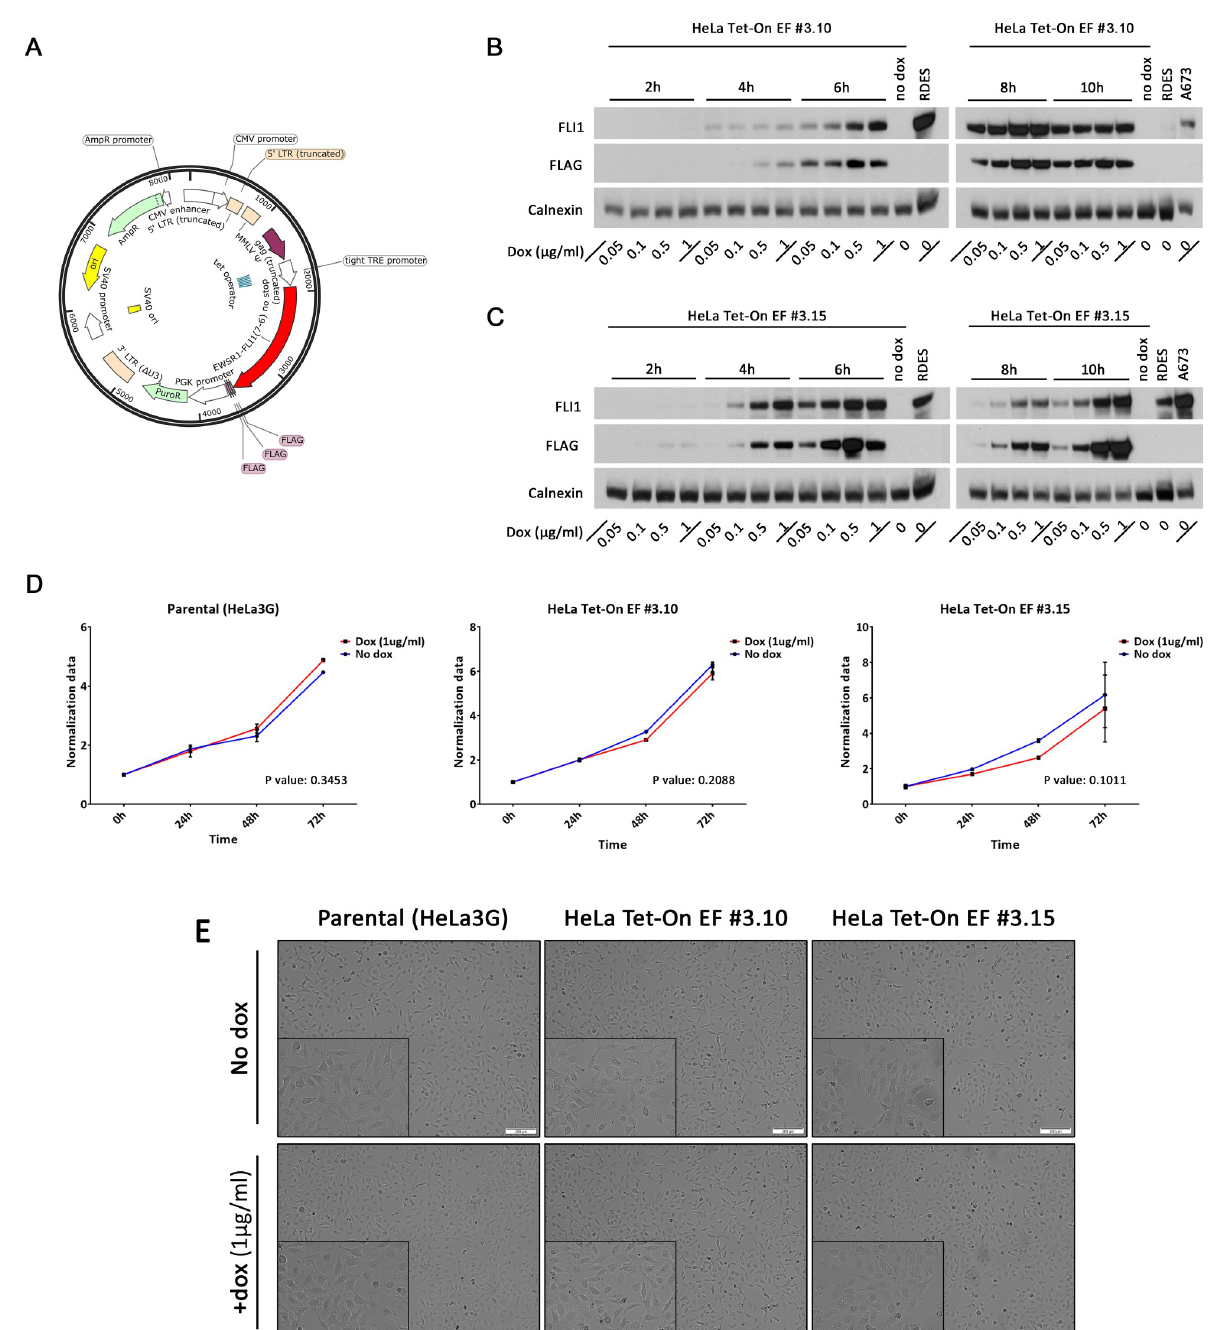
Fig 1. EWSR1-FLI1 expression in a HeLa Tet-On model. A. Schematic diagram of the retroviral vector used in the study. B, C. Western blot analysis showing the inducible expression of EWSR1-FLI1 in two HeLa Tet-On EF clones (#3.10 and #3.15) using the FLI1 and FLAG antibodies in the presence of different concentrations of doxycycline at different time points. The RDES and A673 ES cell lines were used as controls for FLI expression. D. Proliferation of parental HeLa3G cells (control) and HeLa Tet-On EF #3.10 and #3.15 clones in the presence or absence of doxycycline. Values are mean ± s.d. of three biological independent replicates. Statistical tests: 2-way ANOVA multiple comparisons. E. Doxycycline does not affect the morphology of parental cells or the HeLa Tet-On EWSR1-FLI1 models (#3.10 and #3.15). The cell lines were grown in medium with or (for controls) without doxycycline (1 μ g/ml) for 18 days. Phase contrast shows 20 × and 40 × magnifications.